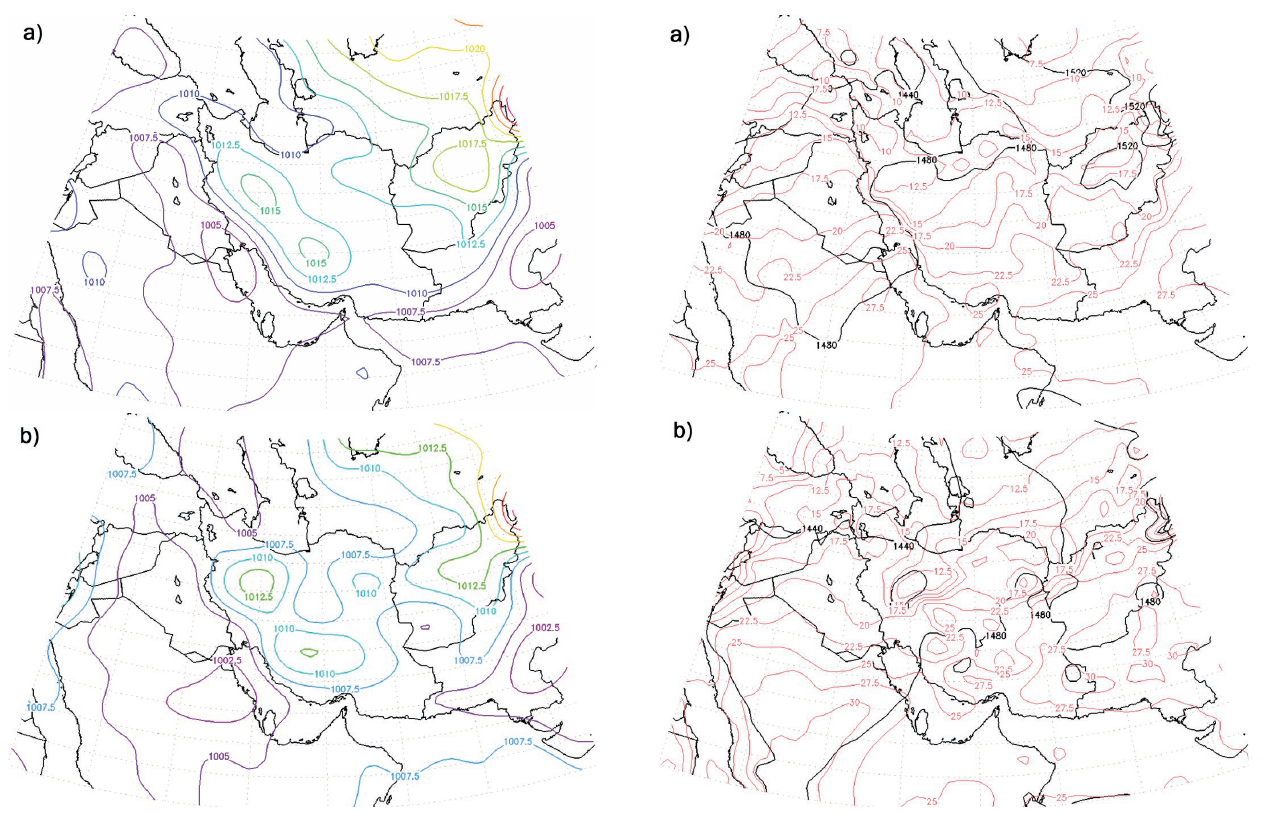
Fig. 4. (a) Surface chart include isobars with 2.5mb intervals on 30 April 2009 at 00:00UTC. (b) Surface chart include isobars with 2.5mb intervals on 30 April 2009 at 12:00UTC.